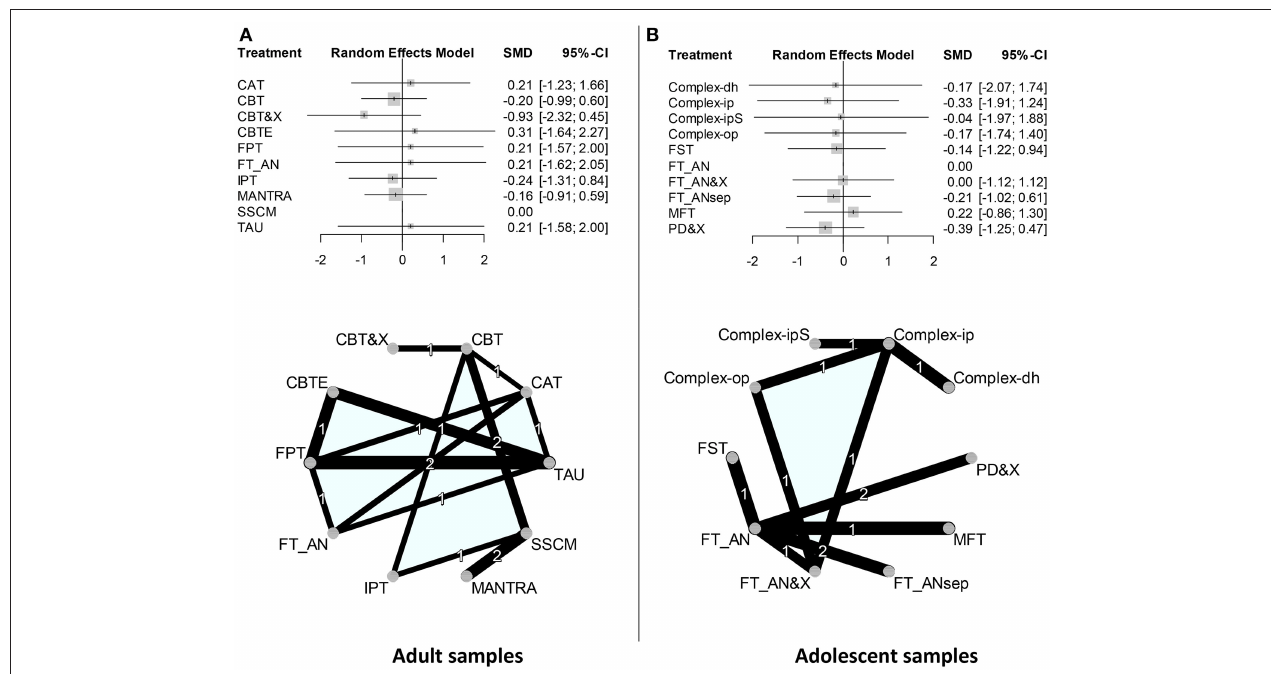
FIGURE 2 | Forest plots and graphs of network meta-analyses. (A) Forest plot adult samples: SSCM was chosen as the reference treatment. Random effects model. If the 95%-CI includes Zero, then the SMD is not significantly different from Zero. No significant effects. Forst plot adolescent samples: FT_AN was chosen as the reference treatment. Random effects model. No significant effects. Complex-ipS = Complex-ip, “short” inpatient treatment. Net adult samples: All treatment categories are located on a circle in alphabetical order (counterclockwise, starting with CAT). All direct comparisons are represented by a connecting line. Only three direct comparisons were investigated more than once. The thickness of a connecting line is proportional to 1/SE of the respective SMD. (B) Net adolescent samples: FT_AN was chosen as the reference treatment. Only two direct comparisons were investigated more than